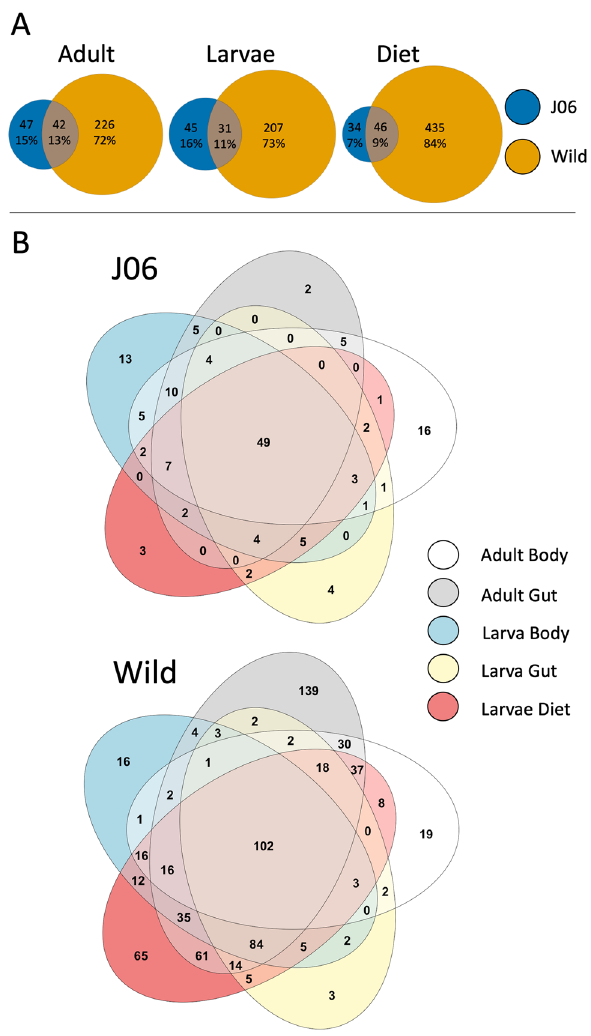
Figure 3. Venn Diagrams showing ASV similarity between ( A ) wild and J06 by life stage, and ( B ) sample type within J06 or wild. ASVs must have been present in half of the samples of each type to be included in the Venn